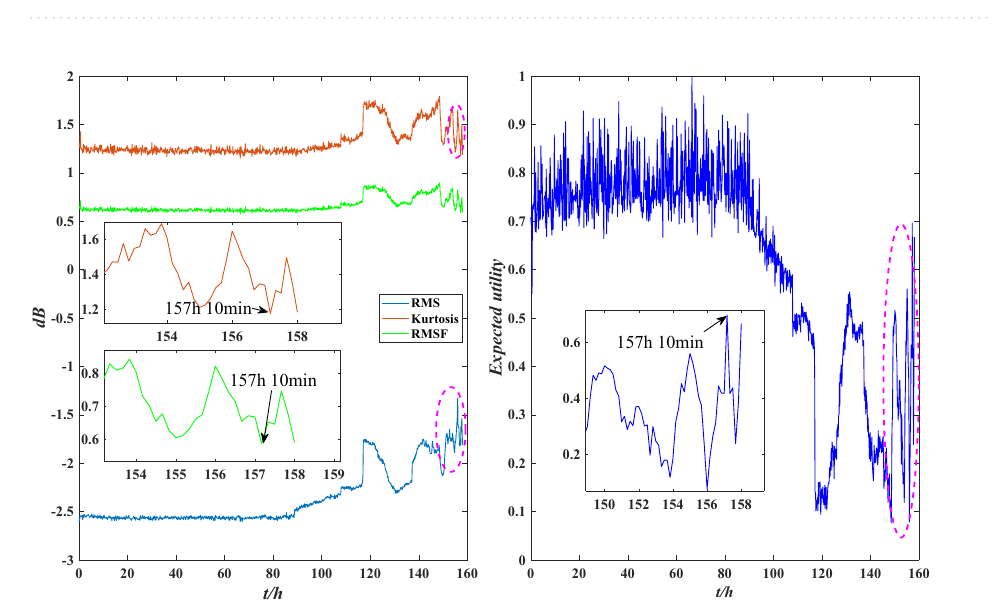
Figure 21. Local indicators and utility